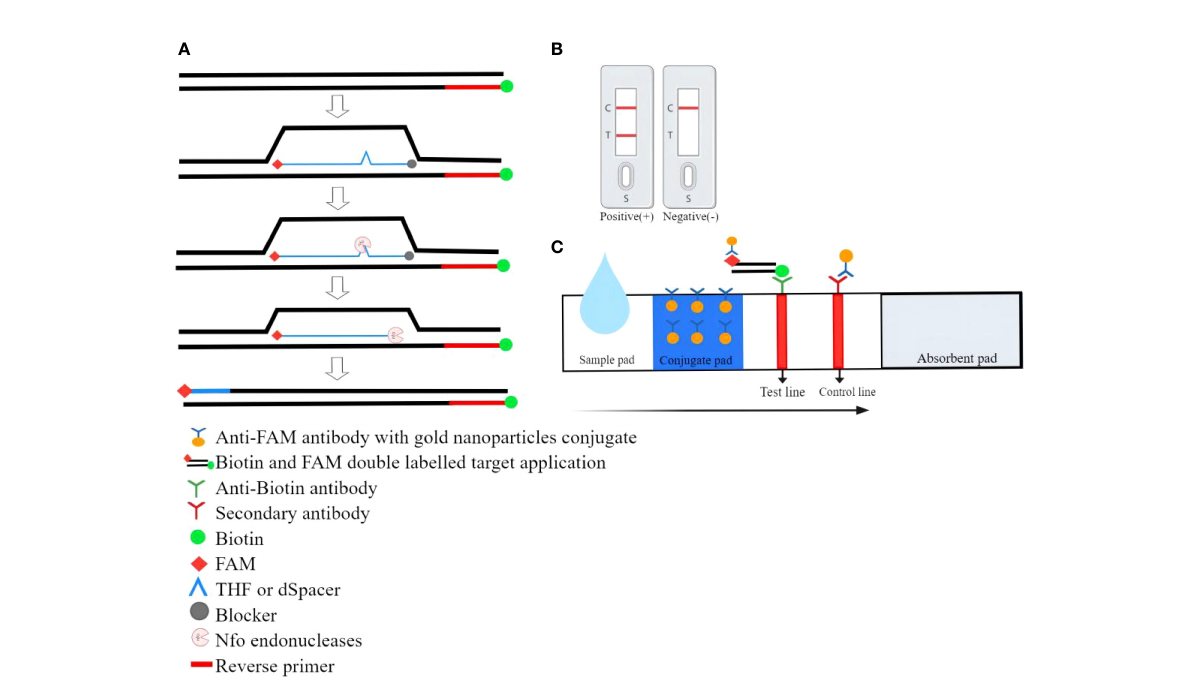
FIGURE 3 The working principle of RPA combined with lateral fl ow strip (LFS) assay. (A) During LFS-RPA, the reverse primer carries the biotin at the 5 ’ end and a modi fi ed probe was added to the reaction. Both ends of the probe were labeled with FAM and blocker respectively. Only when the probe was fully bound to the homologous sequence the endonuclease was able to cut the DNA double-strand and release the blocker. Thereby polymerase extended the substrate and chain synthesis continues leading to double-labeled amplicons. (B) Positive/negative results. (C) Schematic diagram of the RPA combination with lateral fl ow